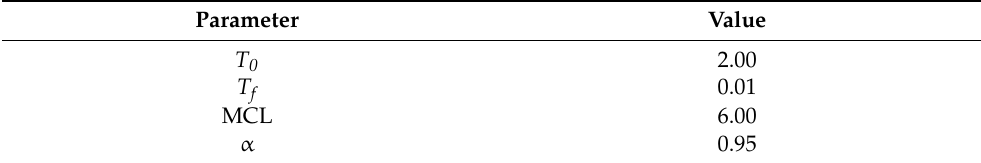
Table 8. Tuned values of the SA parameters for the driven-cavity problem.